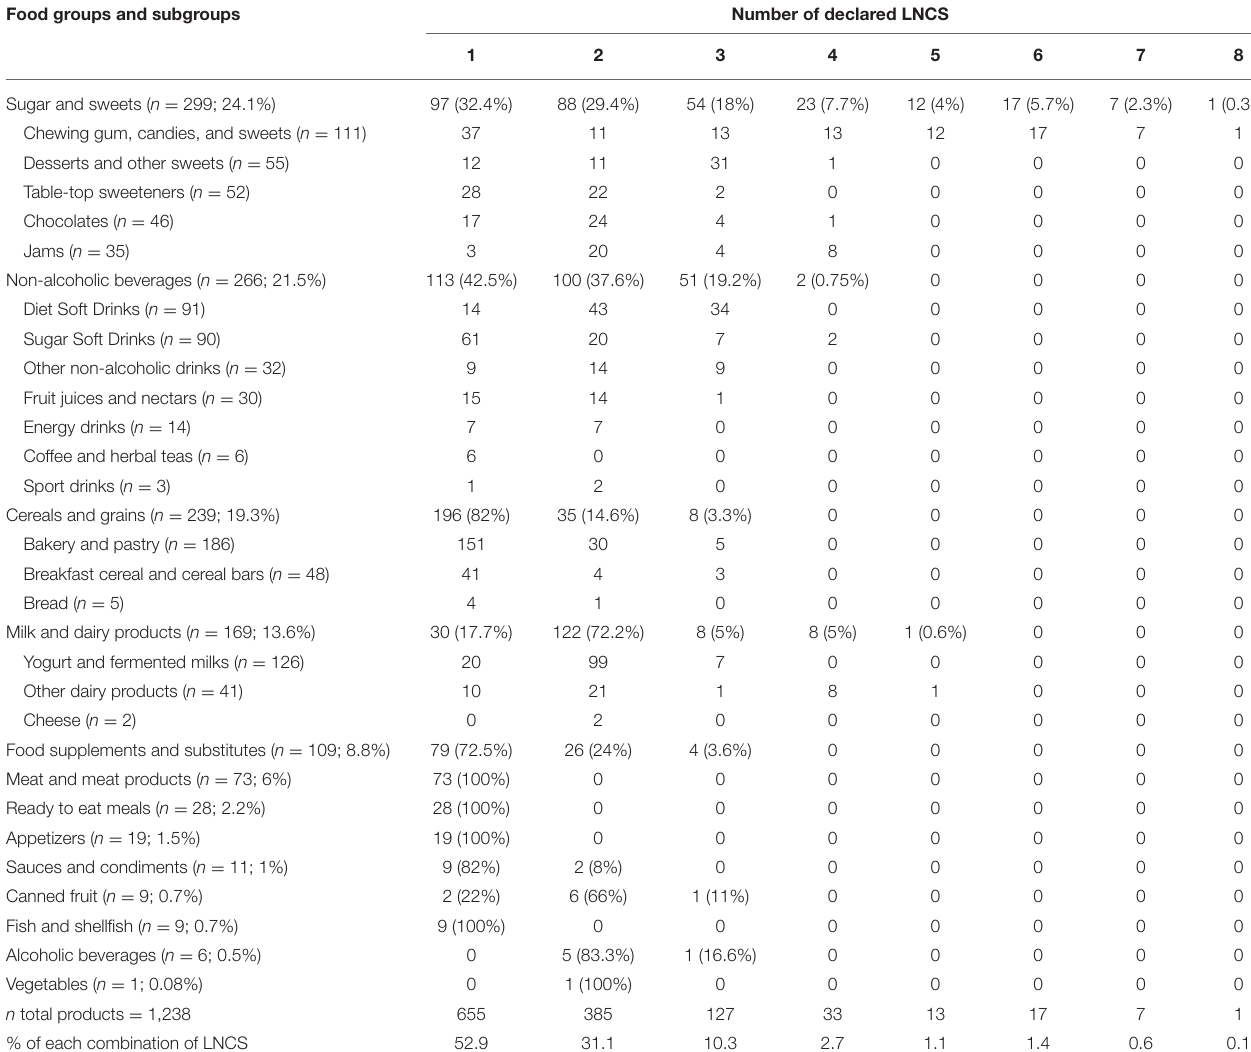
TABLE 1 | Distribution of food and beverage groups and subgroups available in the Spanish market ( n , %), according to the number of declared low and no-calorie sweeteners (LCNS). Food groups and subgroups Number of declared LNCS